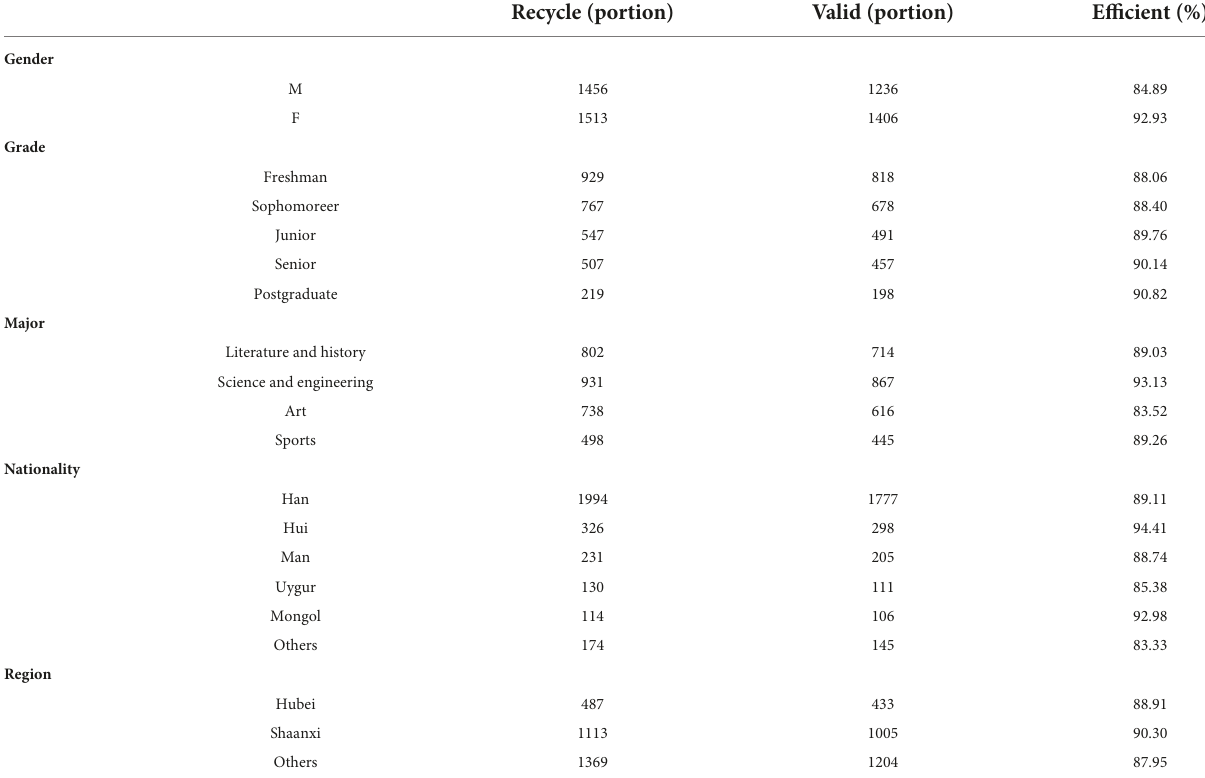
TABLE 1 Demographic distribution of effective sample size in this